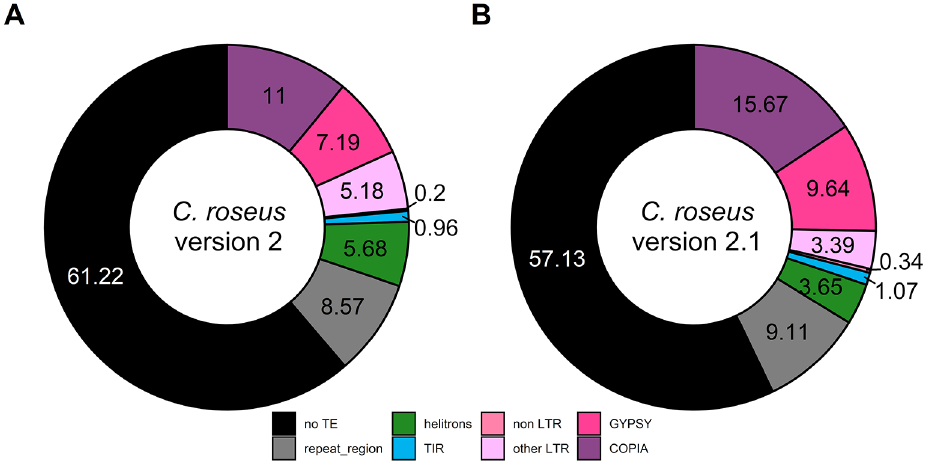
Figure 2. Proportion of transposable element (TE) in C. roseus assembly version 2 (A) and version 2.1 (B). TIR: terminalinvertedrepeat,LTR:longterminalrepeat,nonLTR:retrotransposonswithoutLTRsequence,otherLTR:LTR containing retrotransposons except for Gypsy and